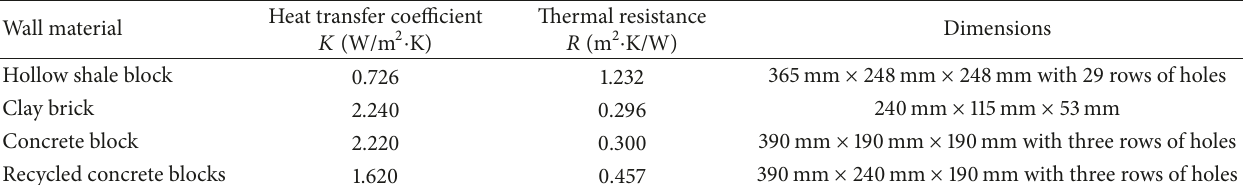
Table 3: Comparison with other wall materials.